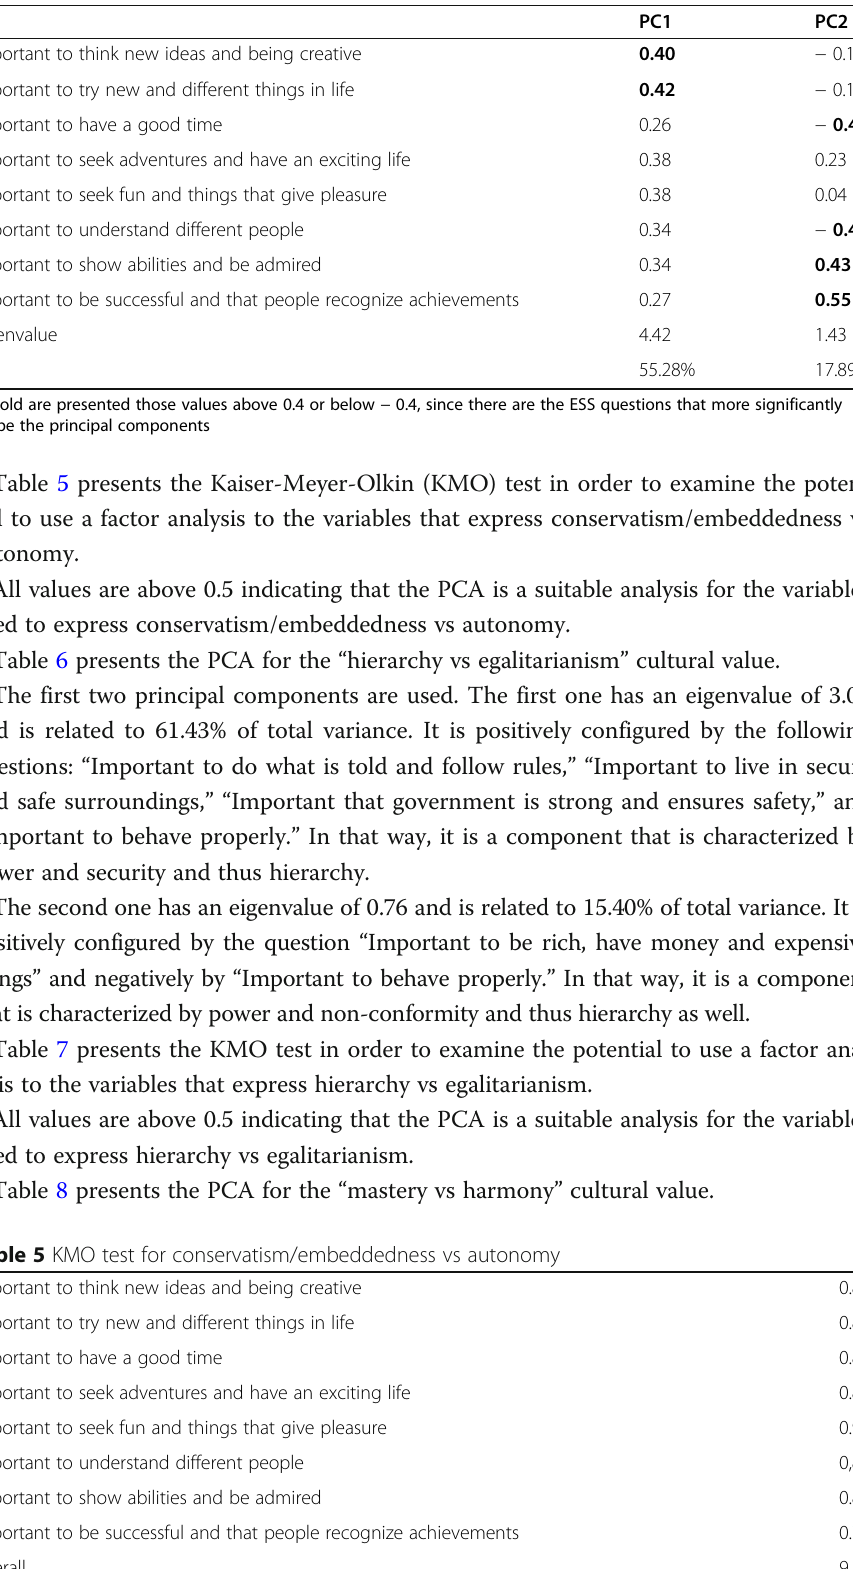
Table 4 PCA for conservatism/embeddedness vs autonomy